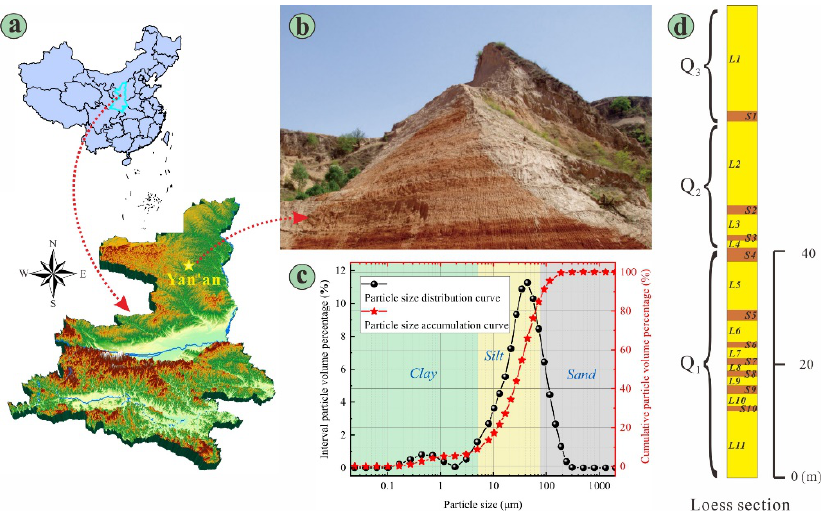
Figure 2. Overview of the study site: ( a ) The location of Yan’an city in Shaanxi Province, China. ( b ) Engineering Section of Yan’an New Area [39]; ( c ) Particle size distribution and gradation accumulation curve of loess sample. ( d ) Section Column Map of Yan’an New Area.